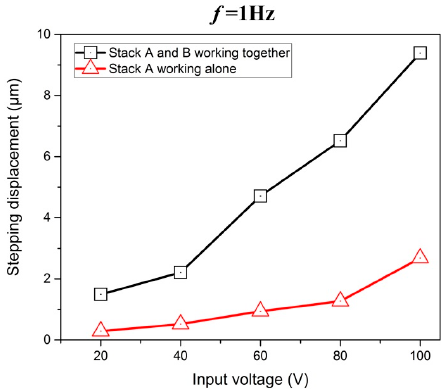
Figure 10. Stepping displacement under two working modes at different input voltages.